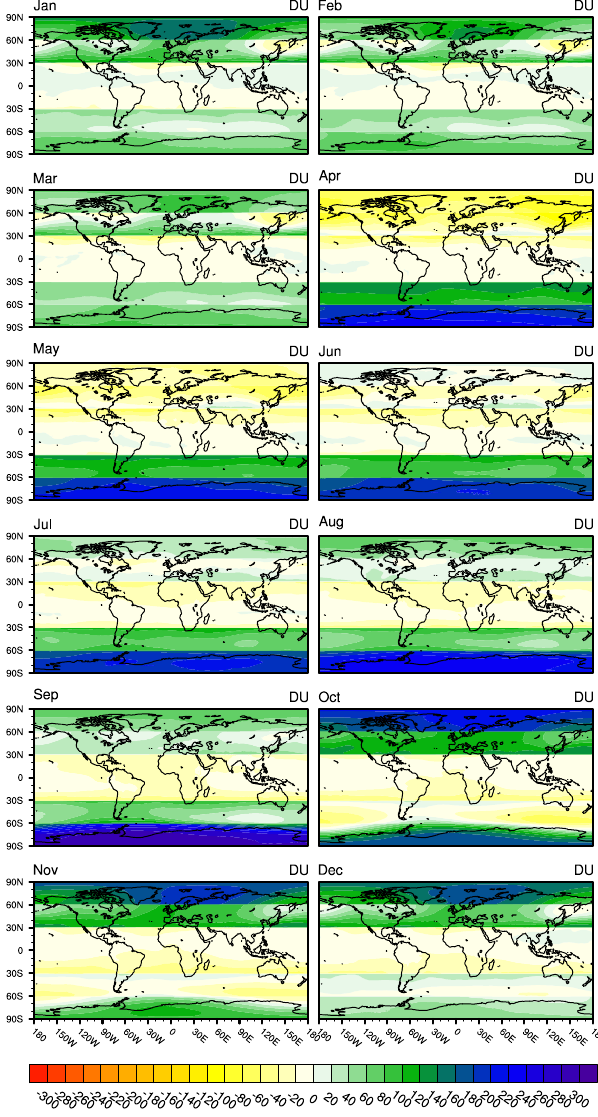
Figure 4. Bias in the total ozone column using the MSR monthly averages for the period (1979–2008) as a baseline for RRTMG.